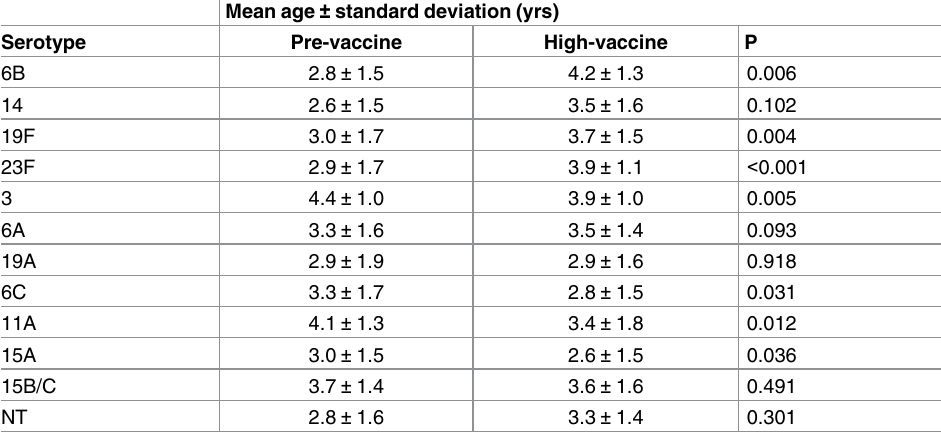
Table 3. Mean age of carriageof specific serotypesin the pre-vaccine and high-vaccine